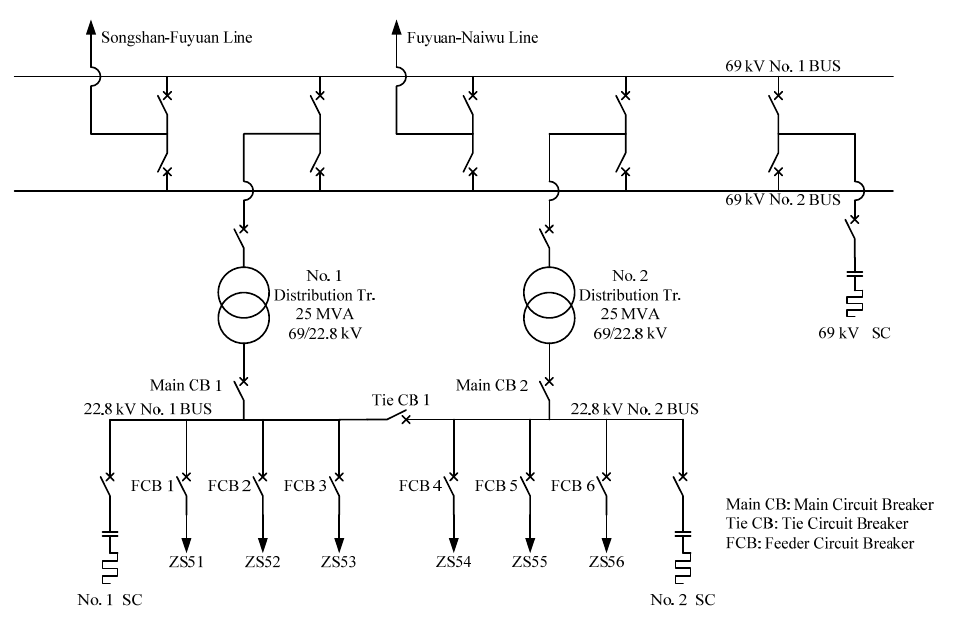
Figure 10. One-line diagram of Fuyuan